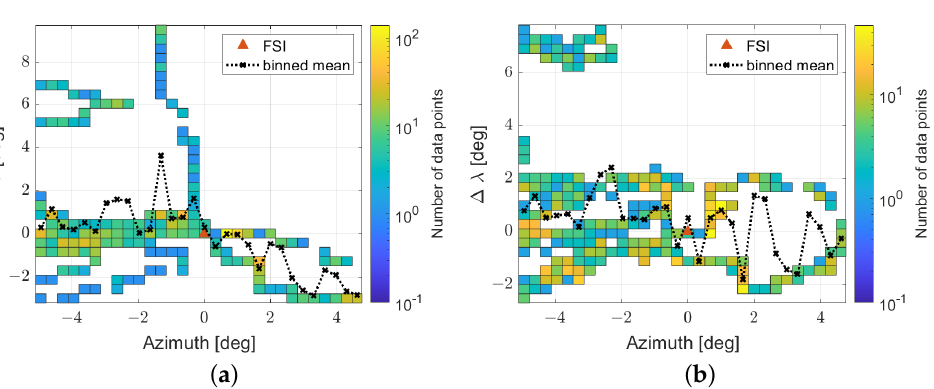
Figure 15. Elevation angle at the ground station and the control pod during neutral flight for various values of the tether angle φ . The data are presented as the difference ( ∆ ) between the simulated and measured value [20]. ( a ) Ground elevation angle θ . ( b ) Control pod elevation angle λ